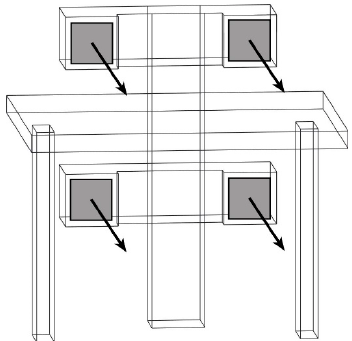
Figure 3. Scheme of the desk equipped PVS with two upper and two lower air terminal devices (grey), position and flow direction. Table 1. Input conditions used in the CFD simulation.